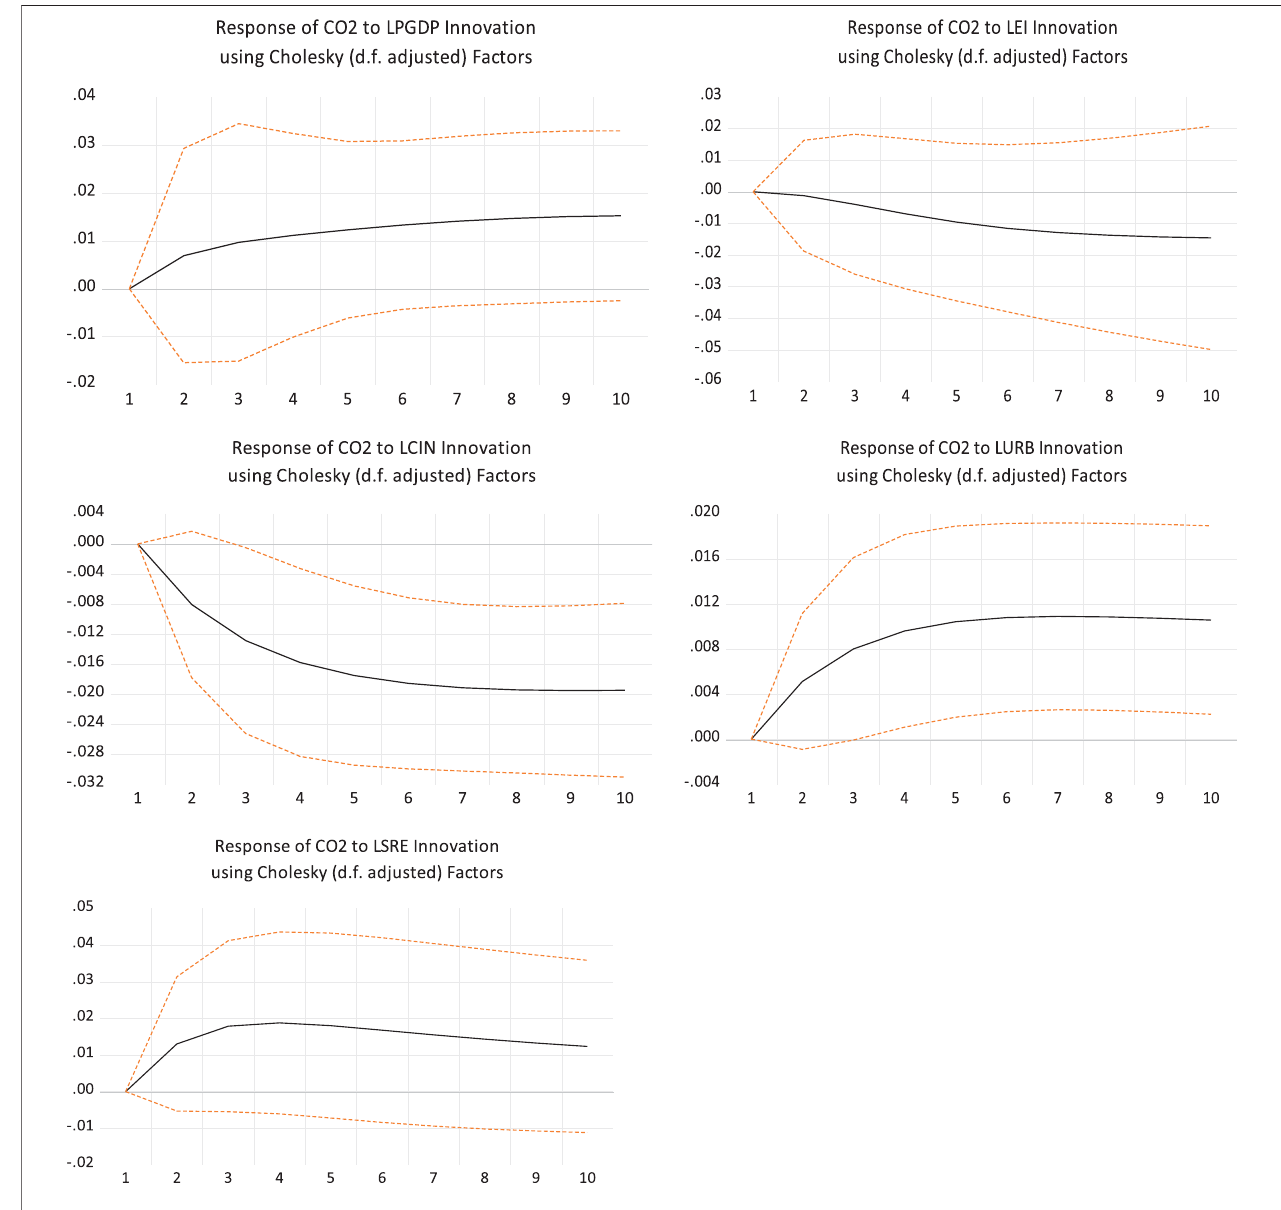
FIGURE 3 | Impact of one standard deviation shock to all variables on CO 2